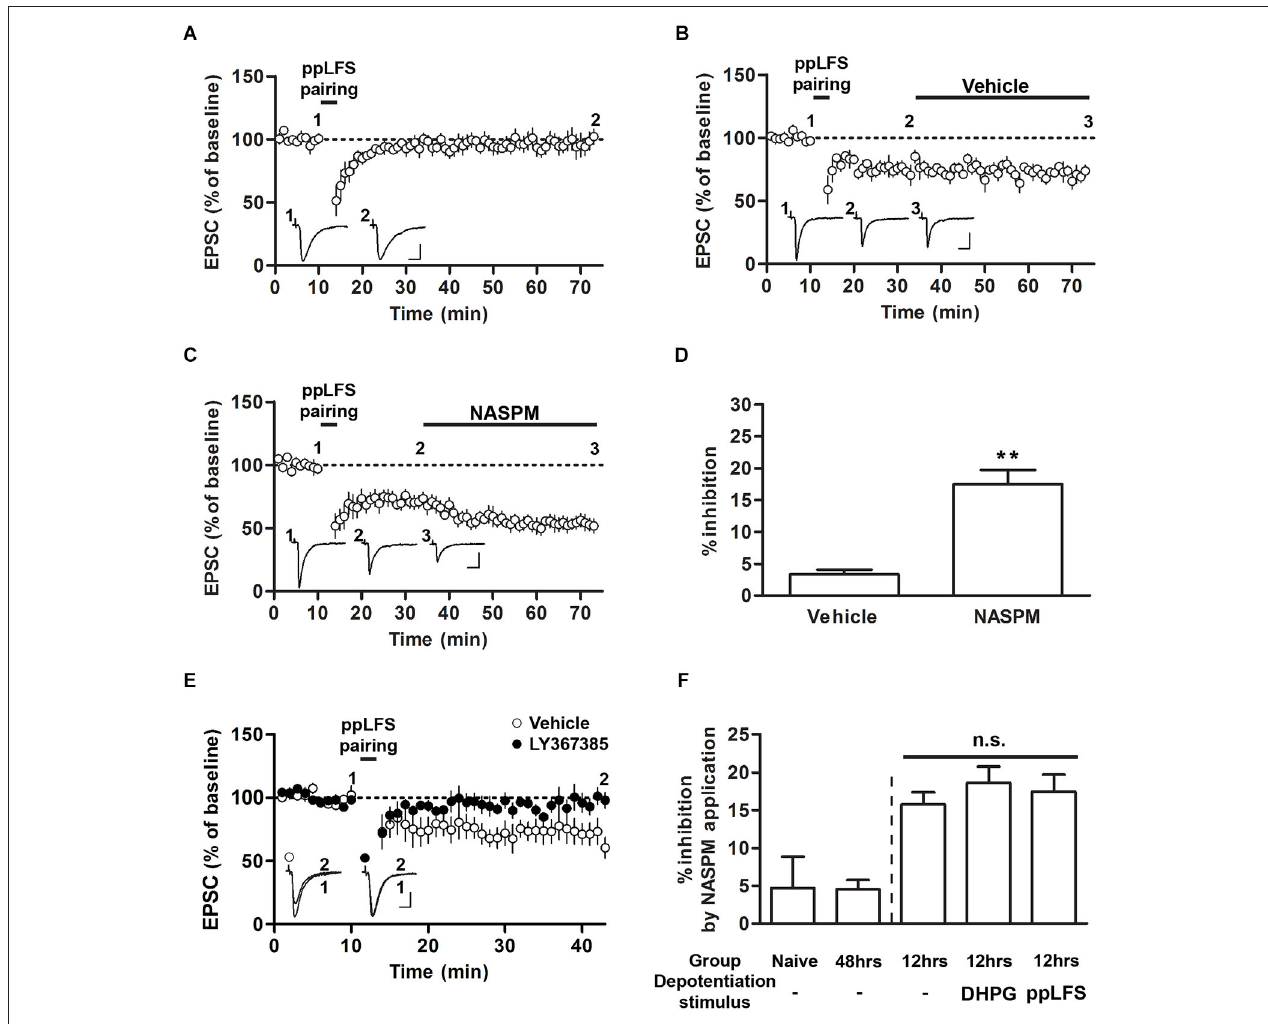
(D) Average percent inhibition due to NASPM (or vehicle) treatment for the experiments shown in B (vehicle) and C (NASPM). (E) ppLFS-pairing-induced depotentiation was blocked by the mGluR1 antagonist, LY367385. LY367385 (100 µ M) or vehicle (aCSF) was present during the entire recording period. The slices were prepared 12 h after conditioning. (F) A summary of NASPM-induced inhibition in all the groups in which the effects of NASPM treatment were evaluated. ** p < 0.01. Scale bars: 50 pA and 10